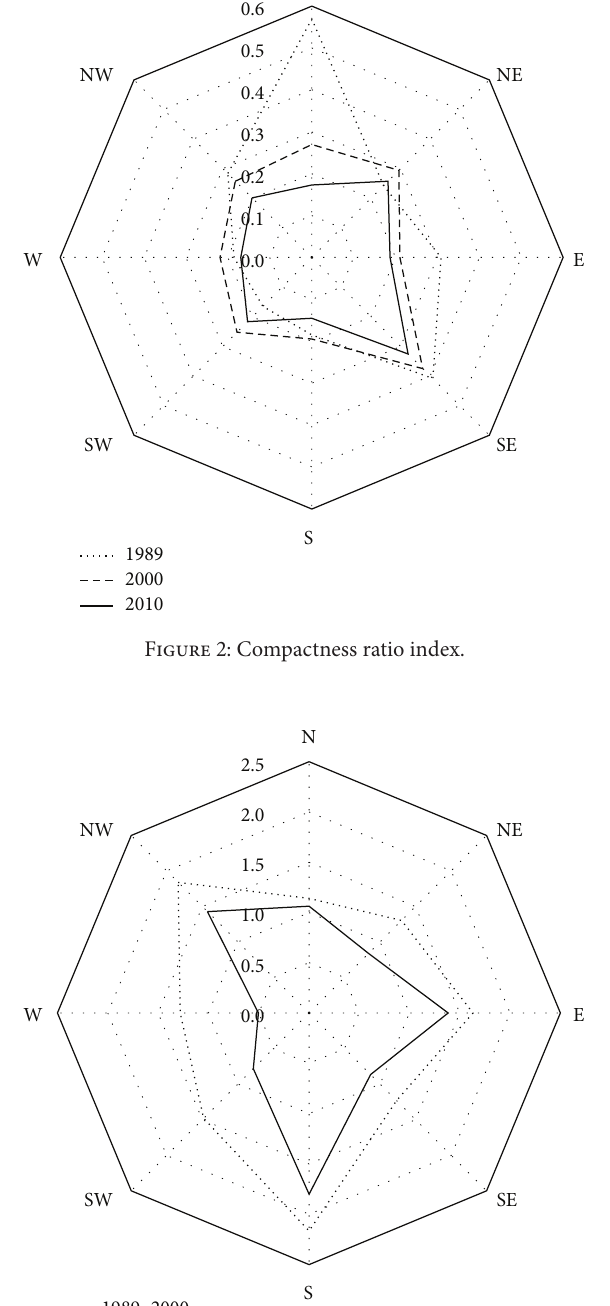
Table1:Thethresholdsofdifferentthermodynamiclevels(unit: ∘ C).